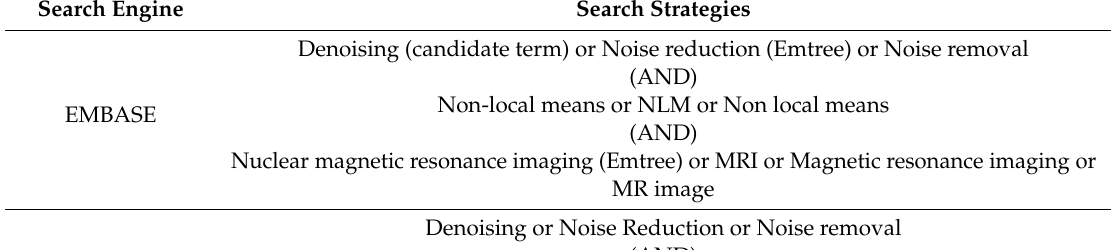
Table 1. Search strategies using the EMBASE, MEDILINE EBSCO, and Cochrane engines. Search